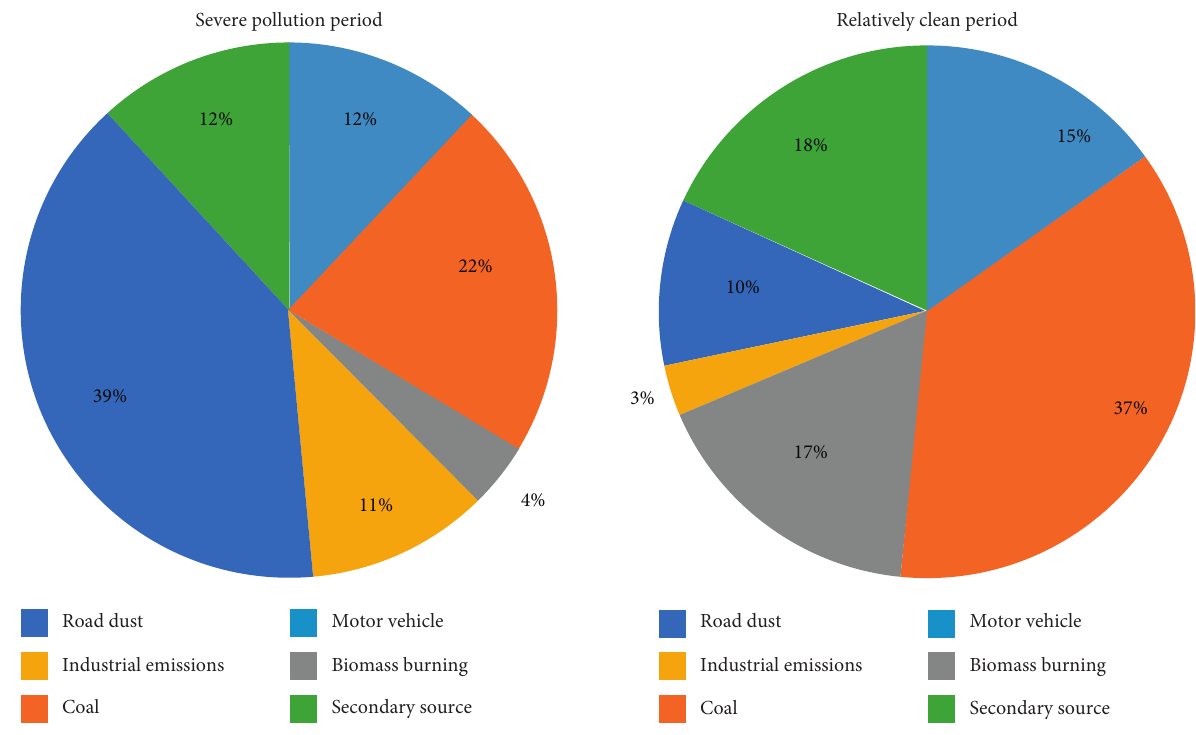
Figure 2: January 2013 Beijing haze